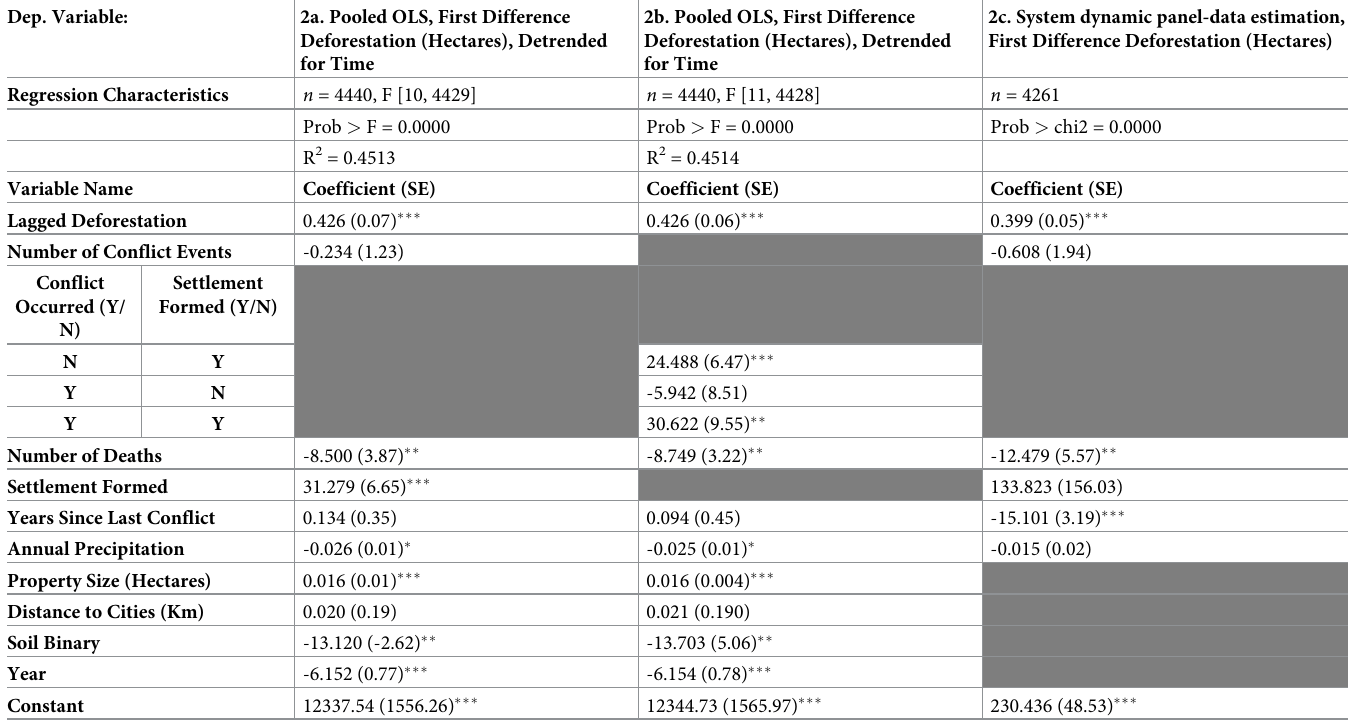
Statistical significance indicated as follows